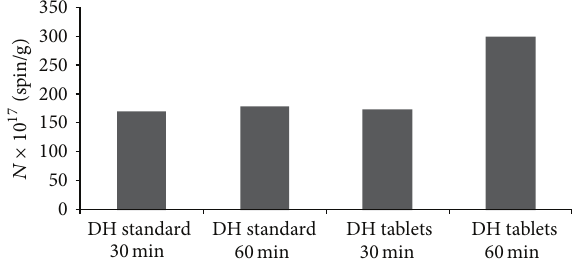
Figure 4: Comparison of free radical concentrations (𝑁) in the UV irradiated dehydrocholic acid (reference standard and tablets containing DH) during 30 and 60